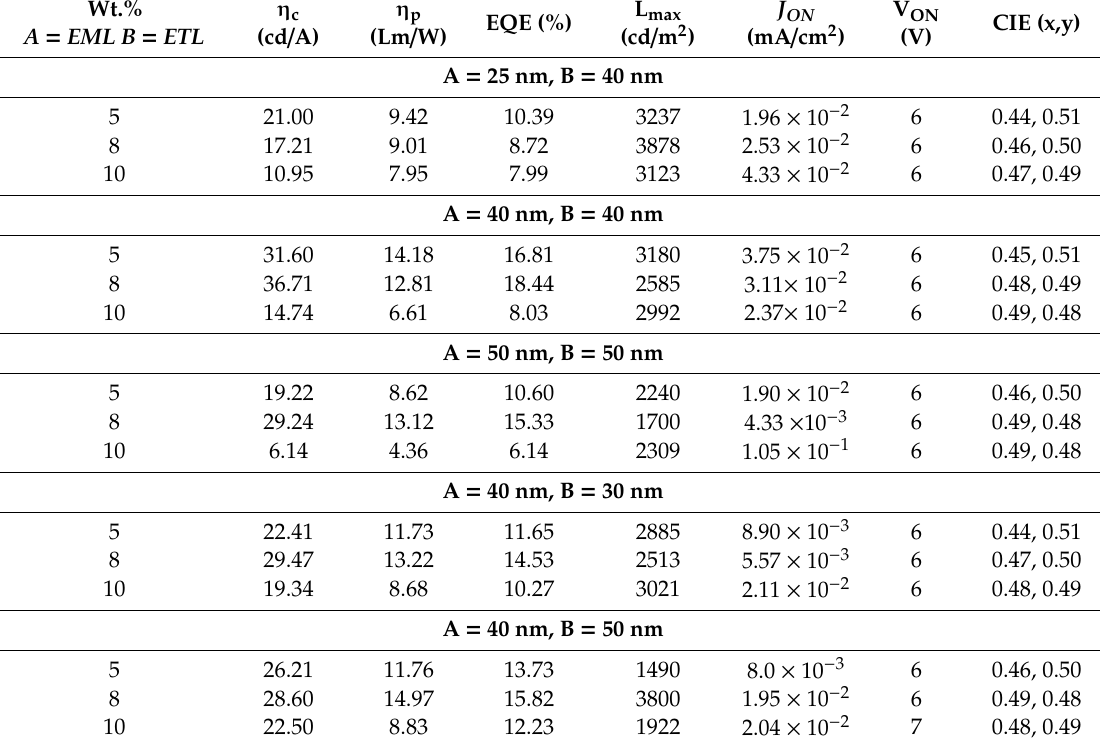
Table 4. Summary of results obtained for device with structure ITO / PEDOT:PSS (40 nm)